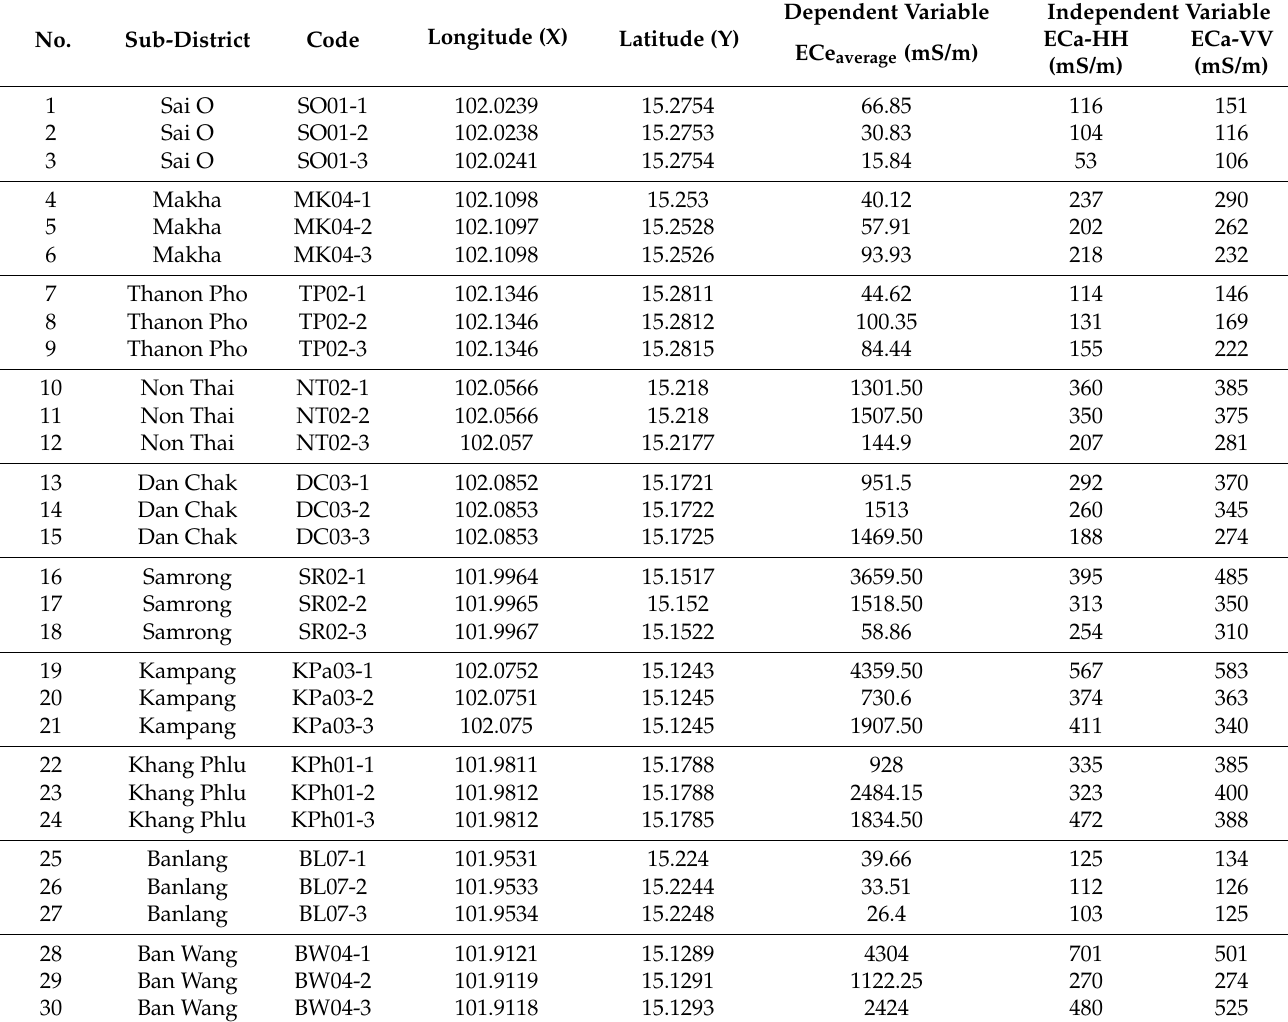
Table 6. The average ECe and ECa of two measuring modes for linear regression analysis.